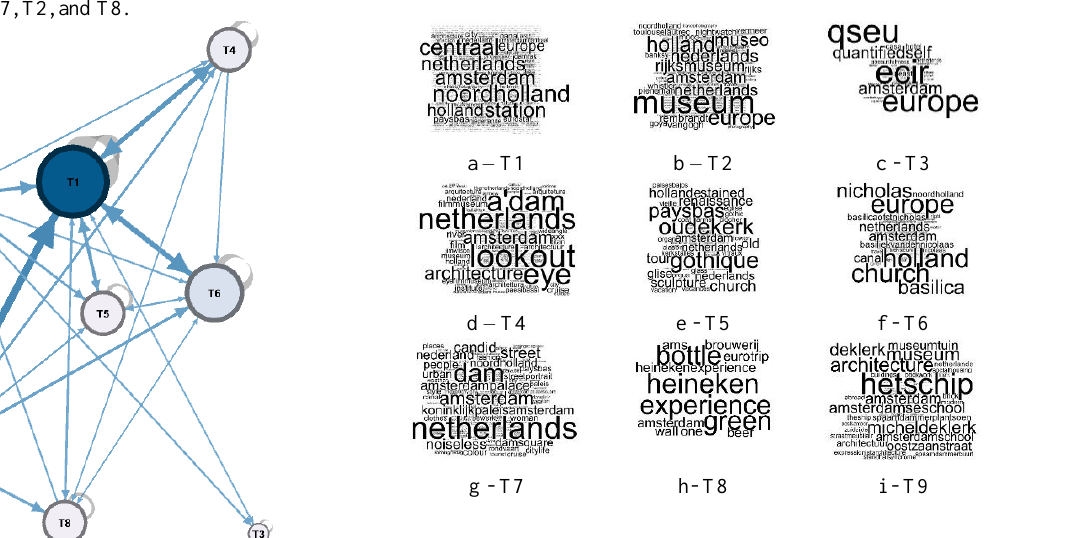
Figure 4. Network analysis